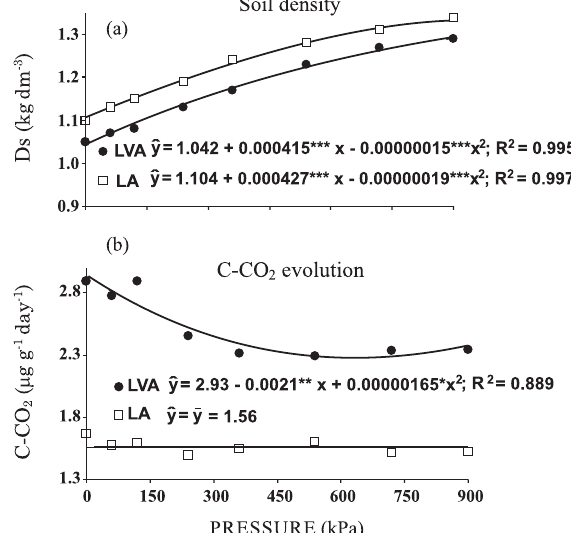
Figure 1. Soil density (a), and C-CO from two Oxisols subjected to increasing compaction pressures. (***, **, *: significance of the coefficients by the F-test, respectively, at the level of 0.1, 1 and 5